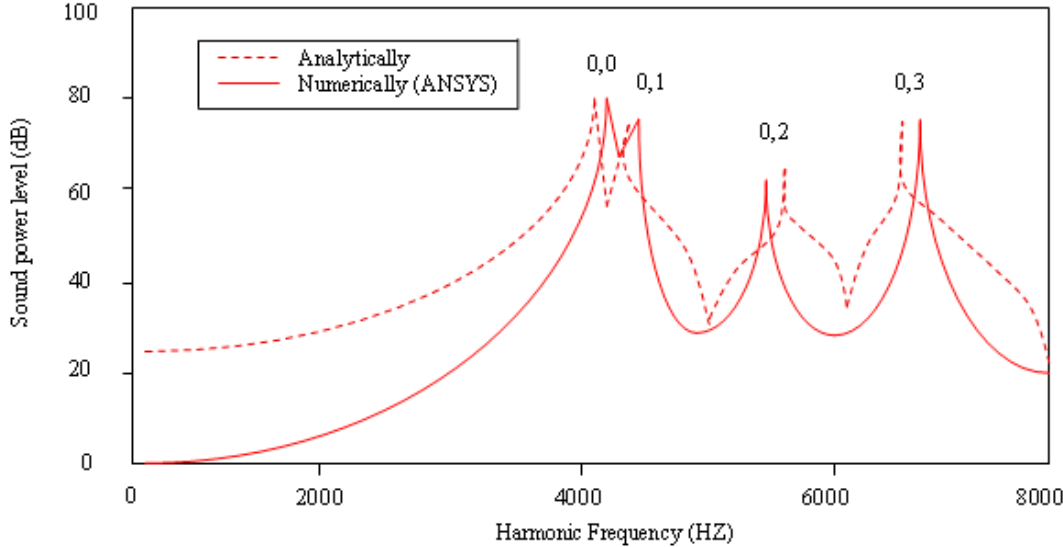
Figure 8. Comparison of sound power level analytically and numerically for annular plate attached with 4 rectangular stiffener patches and having parabolic decreasing thickness variations (Case I) for taper ratio T x = 0.75.